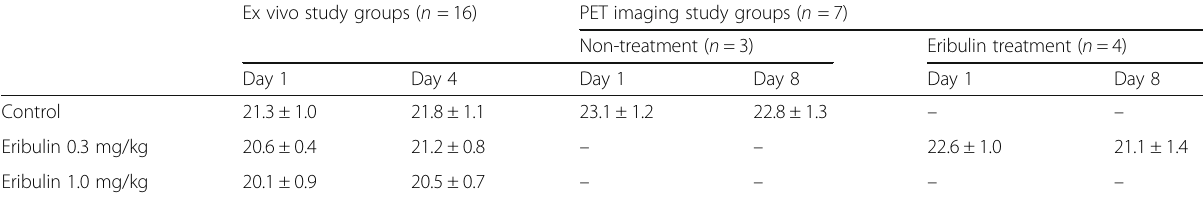
Table 1 Mouse body weight (g) Ex vivo study groups ( n = 16) PET imaging study groups ( n = 7) Non-treatment ( n = 3)